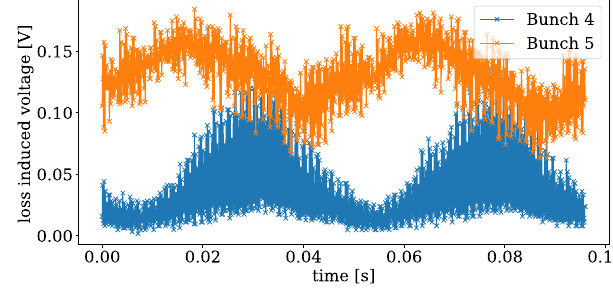
FIG. 19. dBLM acquisition mode 2 raw signal recorded for two arbitrarily selected bunches during one step performed in fill 6194 (see Table III for more details).